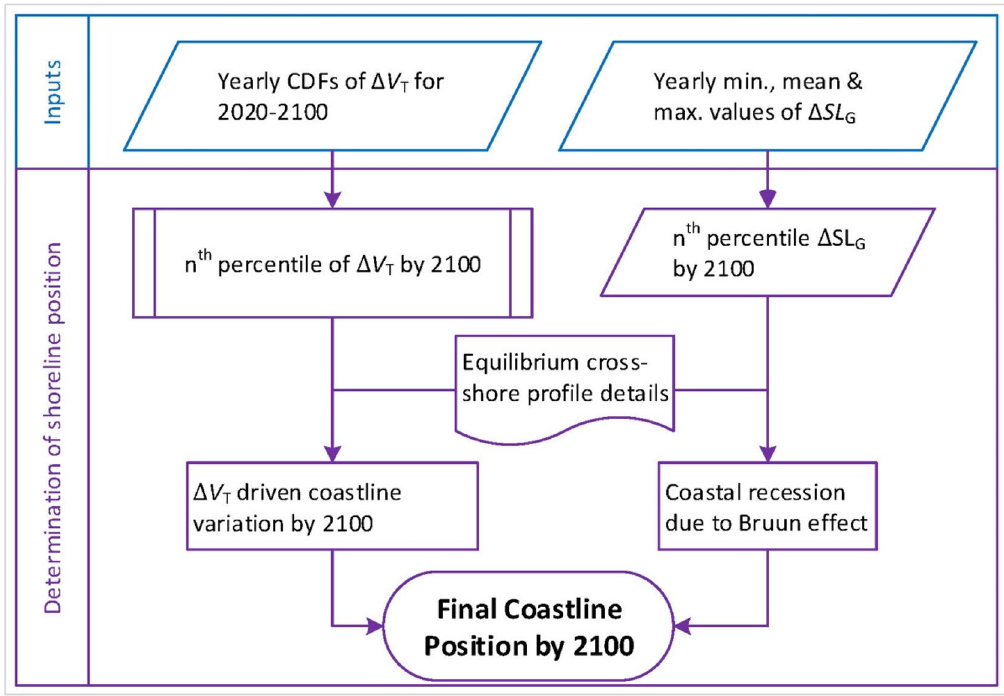
Figure 6. Modelling framework for determining the shoreline position change by 2100 (relative to present-day) along inlet-interrupted coastlines. Note: Annual empirical cumulative distributions (CDFs) are obtained from the sediment volume computations ( (cid:31) V T ) resulting from the modelling approach shown in Fig. used in conjunction with one arc-second resolution digital elevation model obtained from USGS Earth Explorer tool 57 and Human FootPrint Index data 47 to determine the catchment relief ( R ) and human-induced erosion factor ( E h ) values, respectively. The annual average tidal amplitude and the annual number of tidal cycles at the CEC systems are obtained from the harmonic analysis of the TOPEX-POSEIDON global inverse solutions 58 . Catchment-averaged lithological factors ( L ) for the selected systems are obtained from the global map presented together with the BQART model development 46 . The depth of closure and the active coastal-profile slope values at the CEC systems are obtained from a published global dataset 55 . The estuary surface-area values presented in DIVA 11 , UK 32 , and NSW 33 estuary datasets were checked against a published global estuary dataset 59,60 to ensure the reliability of the estuary surface-area values used in the model applications, as this parameter affects two of the three components (i.e., basin infilling volume ( (cid:31) V BI ) and basin volume change ( (cid:31) V BV )) of the total sedi- ment volume exchange ( (cid:31) V T ) calculations in the model. As the DIVA dataset does not contain basin volume information, the basin volume values required for sediment volume calculation are obtained through a fitted linear regression model that estimates basin-volume magnitude given estuary surface area and tidal amplitude values 61 . The input (i.e., basin volume, estuary surface area, and tidal amplitude) for the linear regression model development are obtained by combining three estuary databases from UK 32 , USA 62 , and New South Wales (Aus- tralia) 33 . The final combined dataset used for regression model development contained 324 estuary systems. Model inputs associated with climate change and human activities. Catchment wide mean annual temperature and annual cumulative runoff values for the period 2010–2100 are obtained from four GCMs (GFDL-CM3, GFDL-ESM2G, GFDL-ESM2M, and IPSL-CM5A-MR). The selection of the above four GCMs is based on the availability of temperature and runoff projections for all RCPs over the 2010–2100 inter- ◦ val, the spatial resolution of the GCM outputs (< 2.5 ), and available regional GCM assessment literature (e.g., Climate change projections for the Australian territories 63 ). Time series of minimum, median and maximum projections of global mean sea-level rise per RCP are obtained from Nicholls et al. (2014) 50 . Annual stochastic model inputs of human-induced erosion factor ( E h ) are generated from fitted triangular distributions, in which linearly increasing minimum, median, and maximum values of E h are assumed at each CEC system over the study period. Following the original G-SMIC application 22 , these increments by 2100 are assumed to be 10 (minimum), 15 (median), and 20 (maximum) percent of the reference condition. It should be noted that dif- ferent methods of translating present-day HFPI into the future would result in diverse projections of fluvial sediment supply from the river catchments. A dedicated study investigating different socio-economic pathways, including changes in land use pattern, reservoir sediment trapping, and the introduction of flood control/water diversion structures, could provide more detailed representations of these increased human-induced impacts on the environment.